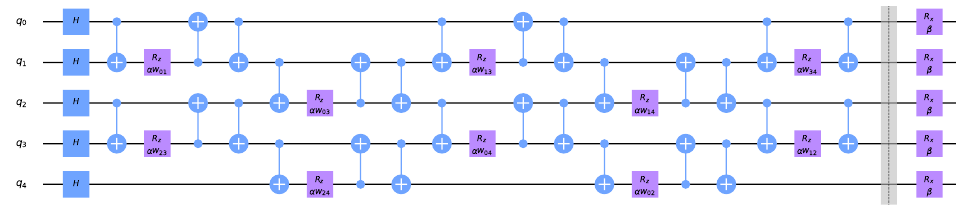
Figure 4. An example of a QAOA circuit used to solve the weighted Max-Cut problem on an m = 5 coreset implemented using the swap networks proposed in [33,34]. Here, p = 1, α , and β are the variational parameters and the w ij ’s are the edge weights of the constructed graph (see Figure 1). Using the swap network, each qubit is able to interact with every other qubit, O ( n 2 ) interactions, in linear